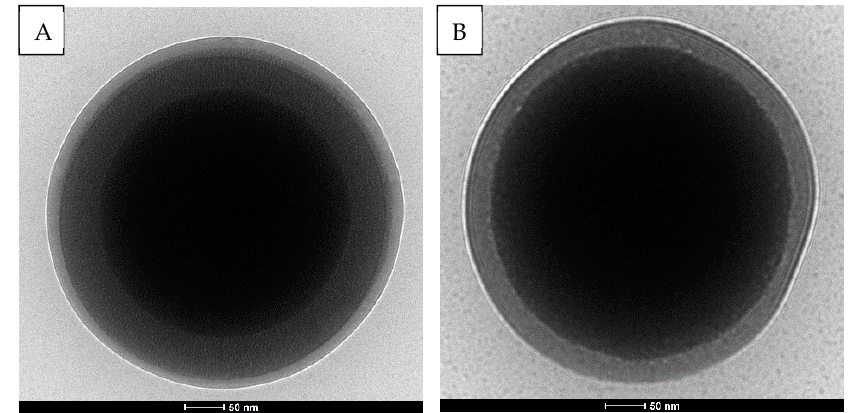
Figure 3. Cryo-TEM images of ( A ) SCMS-PNIPAM(4), and ( B ) SC-PNIPAM(4).